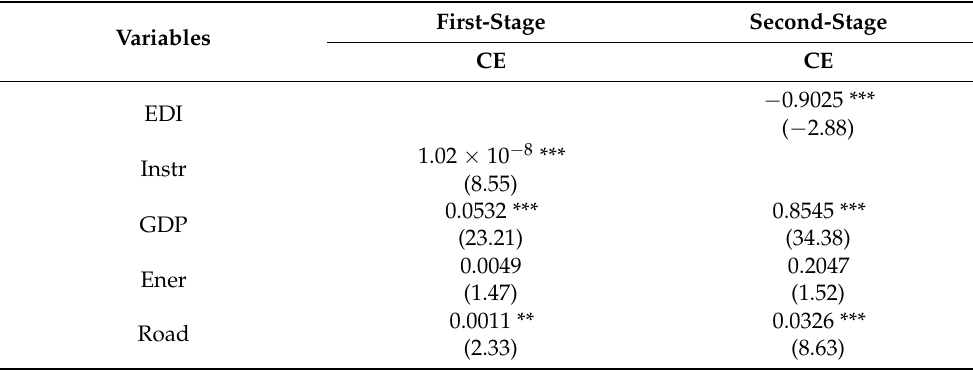
Table 9. Results of instrumental variable